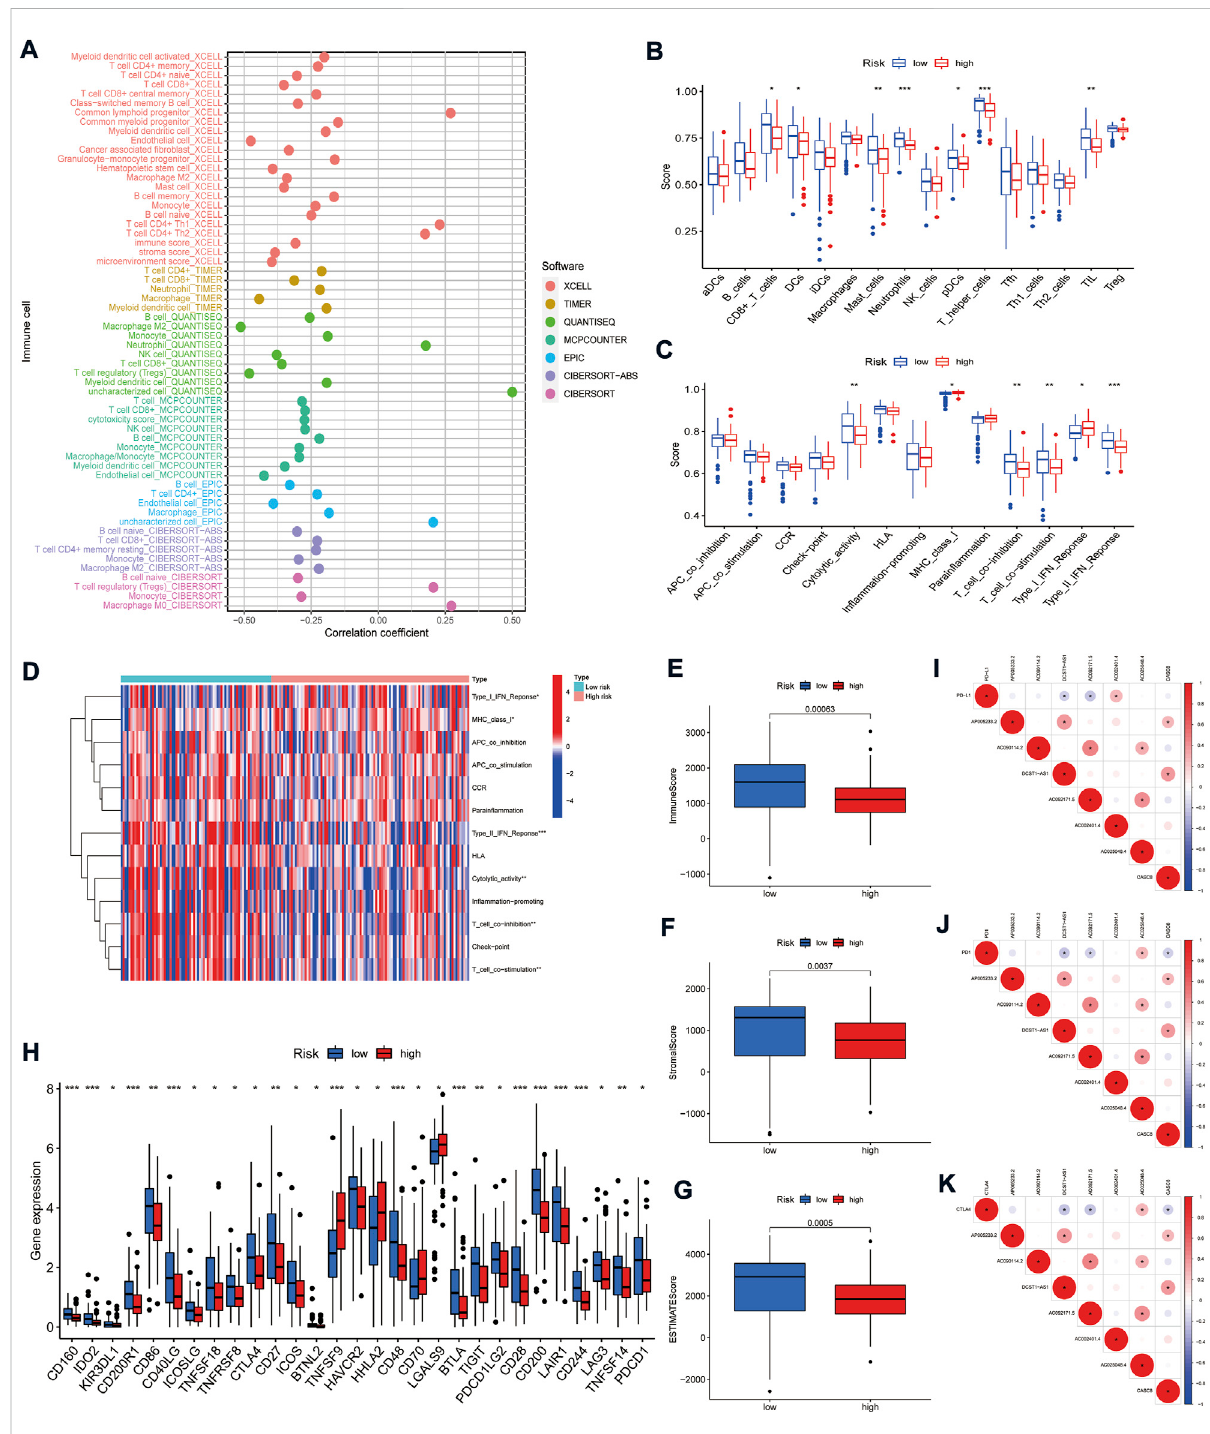
FIGURE 8 Correlation of the risk model with the immune microenvironment in PAAD. (A) Bubble plot of correlation coef fi cients between immune cells and risk scores. (B) Comparison of the enrichment scores of immune cells between high- and low-risk groups. (C) Comparison of the enrichment scoresofimmune-relatedfunctionsbetweenhigh-andlow-riskgroups. (D) Heatmapdepictingthestatusofimmune-relatedfunctionsinthehigh- and low-risk groups. (E – G) Correlation of high- and low-risk groups with immune cell score, stromal cell score, and ESTIMATE score. (H) Comparison of immune checkpoints in high- and low-risk groups. (I – K) Correlation between the expression of three immune checkpoints (PD- L1, PD-1, and CTLA4) and seven signature lncRNAs, respectively. * p < 0.05, ** p < 0.01, and *** p <